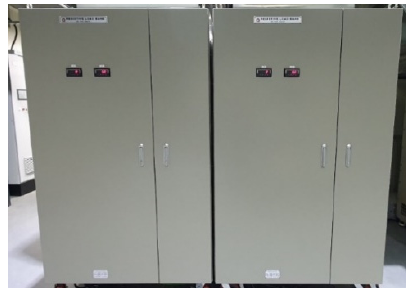
Figure 13. Load bank system in the testbed. Table 4. Load bank specifications of the testbed.